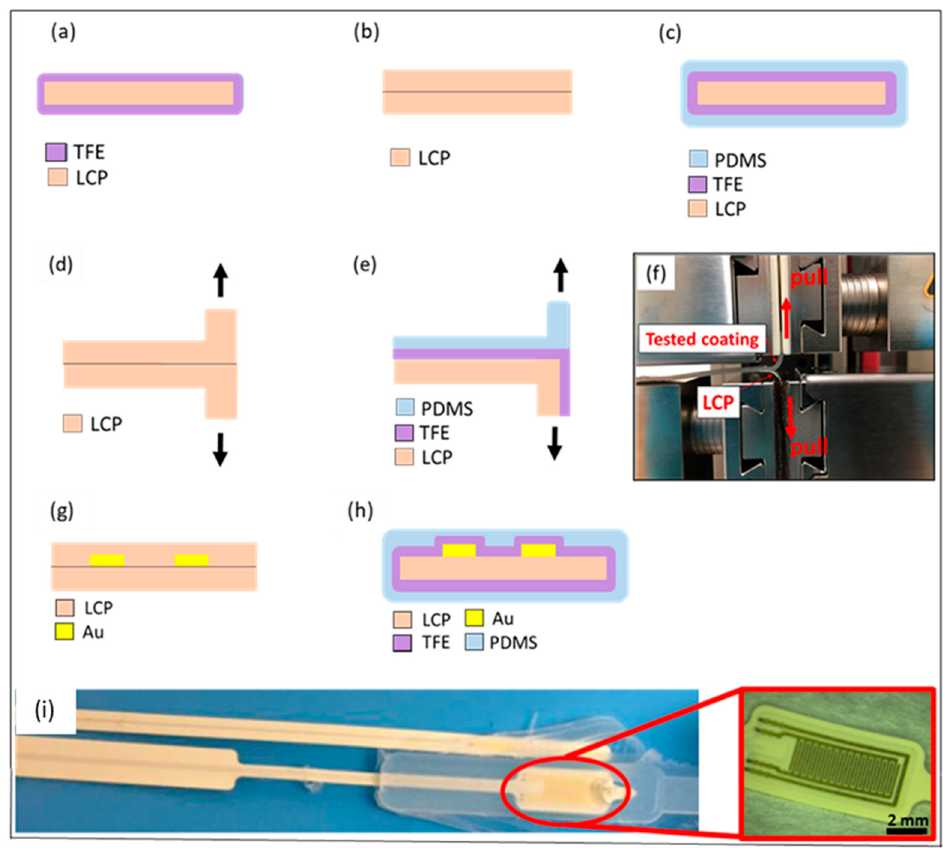
Figure 2. Schematic cross-section illustration of the tested samples: LCP-TFE1/2 samples used for pre-screening test ( a ), LCP-LCP laminate ( b ) and LCP-TFE1/2 with silicone finish samples ( c ) used for sorption tests, LCP-LCP ( d ) and LCP-TFE1/2 ( e ) with silicone finish samples used for adhesion T-peel test. Adapted ASTM D1876 T-Peel test setup with the sample ( f ). Schematic representation of the IDC tested samples: LCP-Au-LCP ( g ) and LCP-Au-TFE1/2 with silicone finish ( h ). Exposed Au IDC test structure on LCP ( i ).